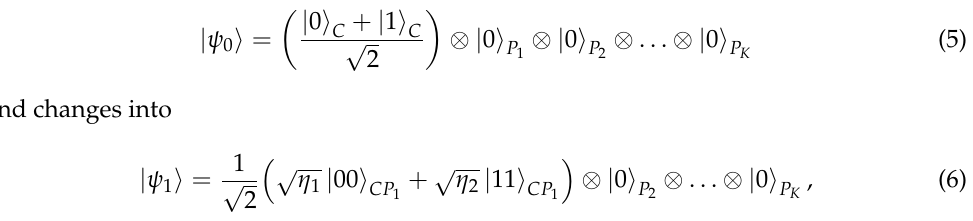
Figure 2. Counterfactual GHZ state distribution. Consider a network that consists of a server and K participants. The server holds a QAO which is in the state hold H-polarized photons denoted as H-CQZ operation upon establishing a connection with the server through the switch L. Once all the K participants have completed their respective H-CQZ operations in a consecutive manner, a K + 1 partite GHZ state is distributed among the K participants and the server, as described in Equation